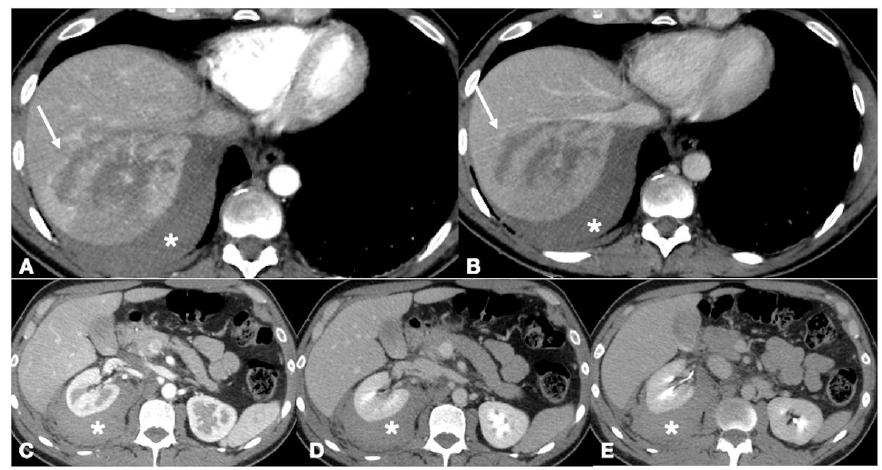
Figure 5. Enhanced-CT of a 37-year old male with multiple injuries due to high energy blunt trauma (car accident). The CT study demonstrates hemoperitoneum ( A , B , asterisks), liver lacerations ( A , arterial phase, arrow; B , portal venous phase, arrow) and a perirenal hematoma ( C – E asterisks). The availability of multiple phases excluded the presence of active bleeding or active urine extravasa- tion. The patient was managed